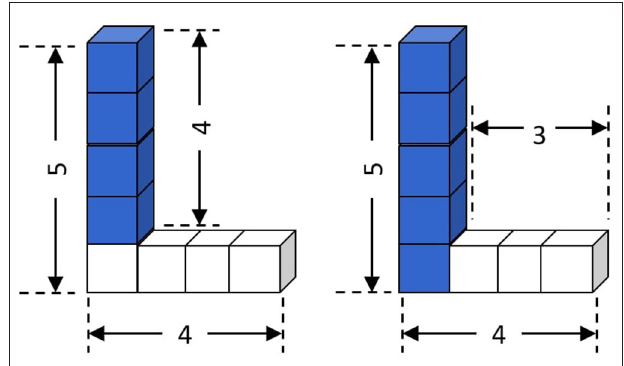
FIGURE 1 | Concept L ( base = 4, height = 5), described as composition of a Tower and a Row